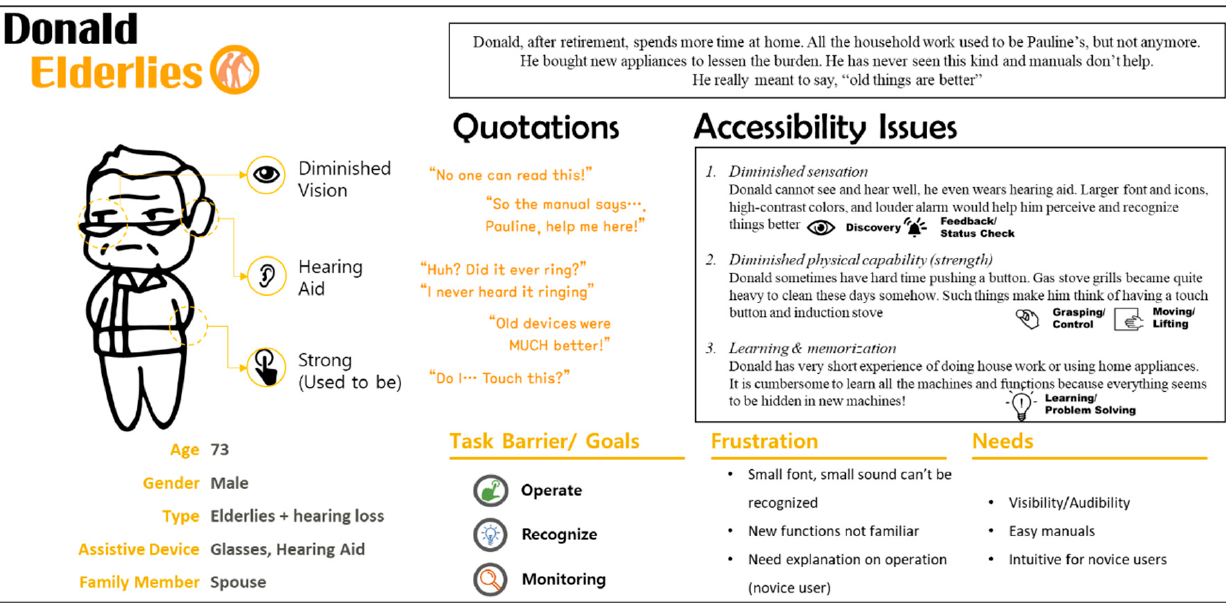
Figure A8. Persona card of Donald, the grandpa